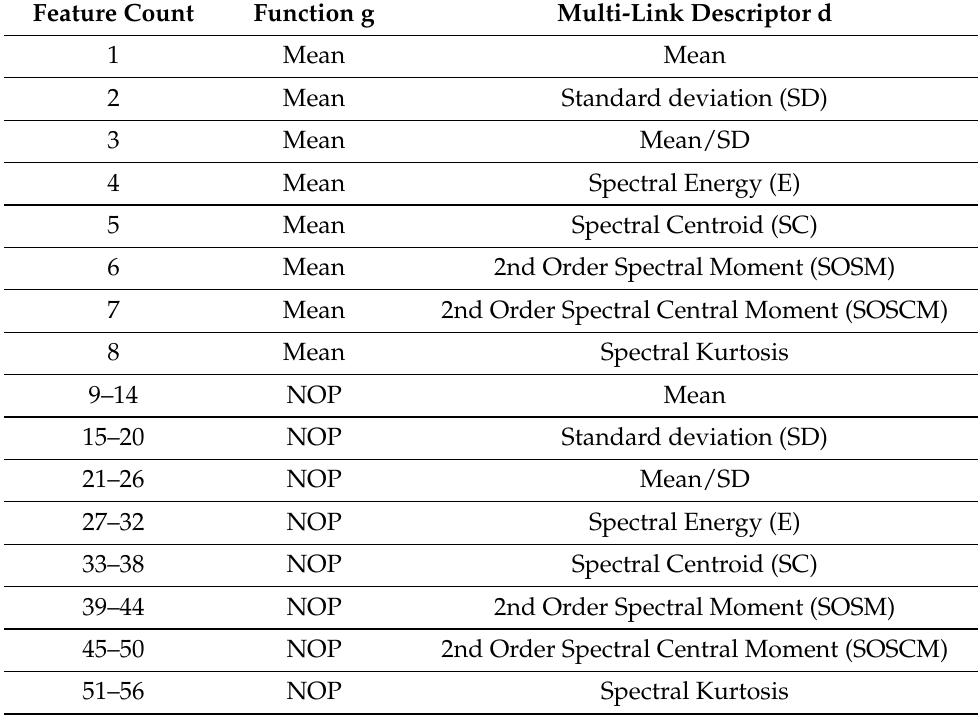
Table 2. Features and descriptor functions used in the